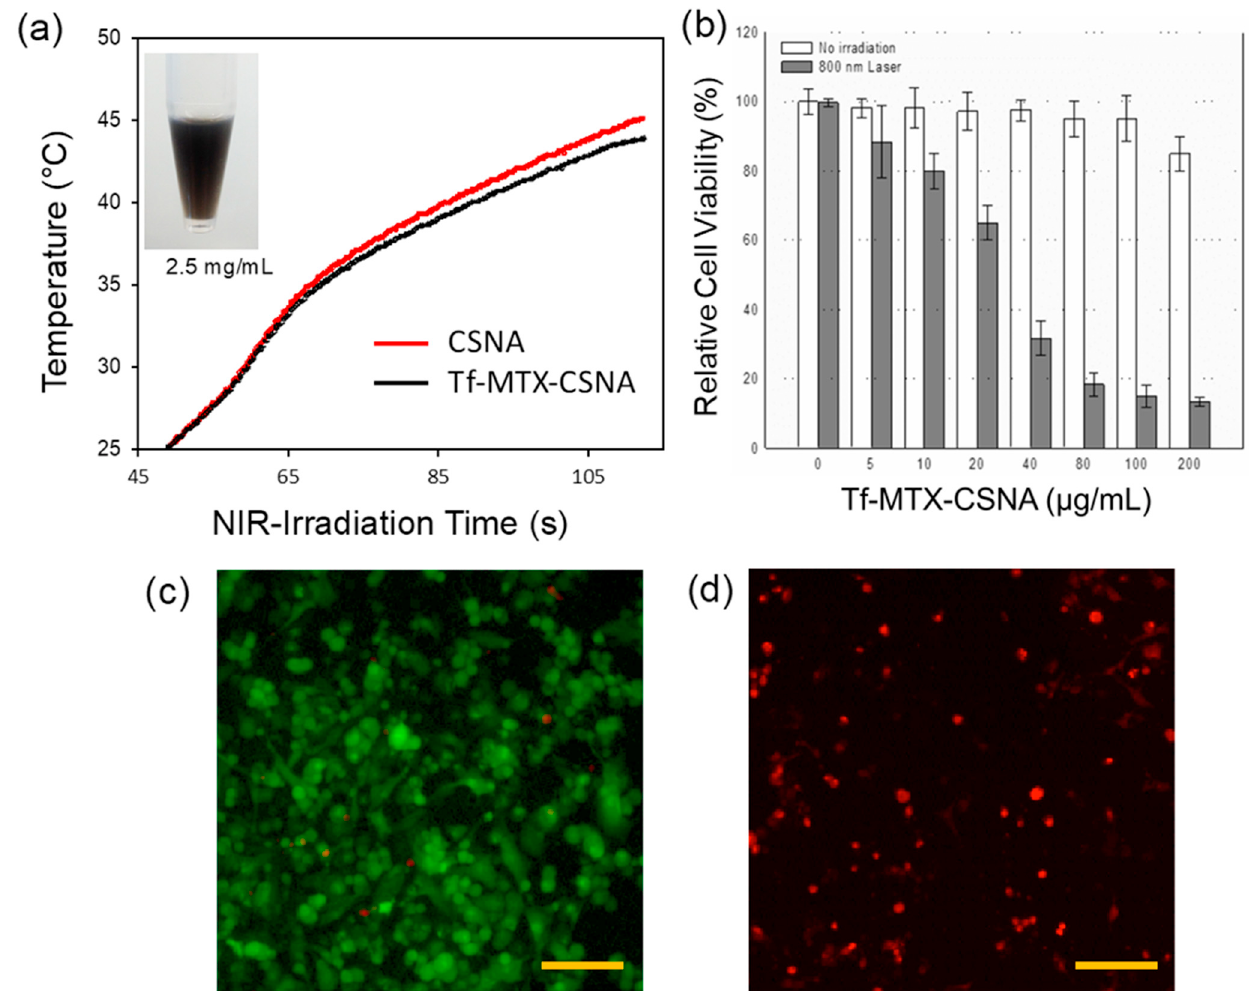
Figure 7. Photothermal activity of the CSNA samples. ( a ) Plot of the temperature increase by NIR-irradiation in the presence of CSNA and Tf-MTX-CSNA solution samples. In particular, the Tf-MTX-CSNAs showed similar magneto-thermal activity with bare CSNAs, confirming the outstanding magnetic stability after the conjugation processes. ( b ) XTT cytotoxicity assay as a function of the Tf-MTX-CSNA sample concentration. The fluorescence microscopic images of Hela cells before ( c ) and after ( d ) the NIR exposure (scale bar: 100 µm).